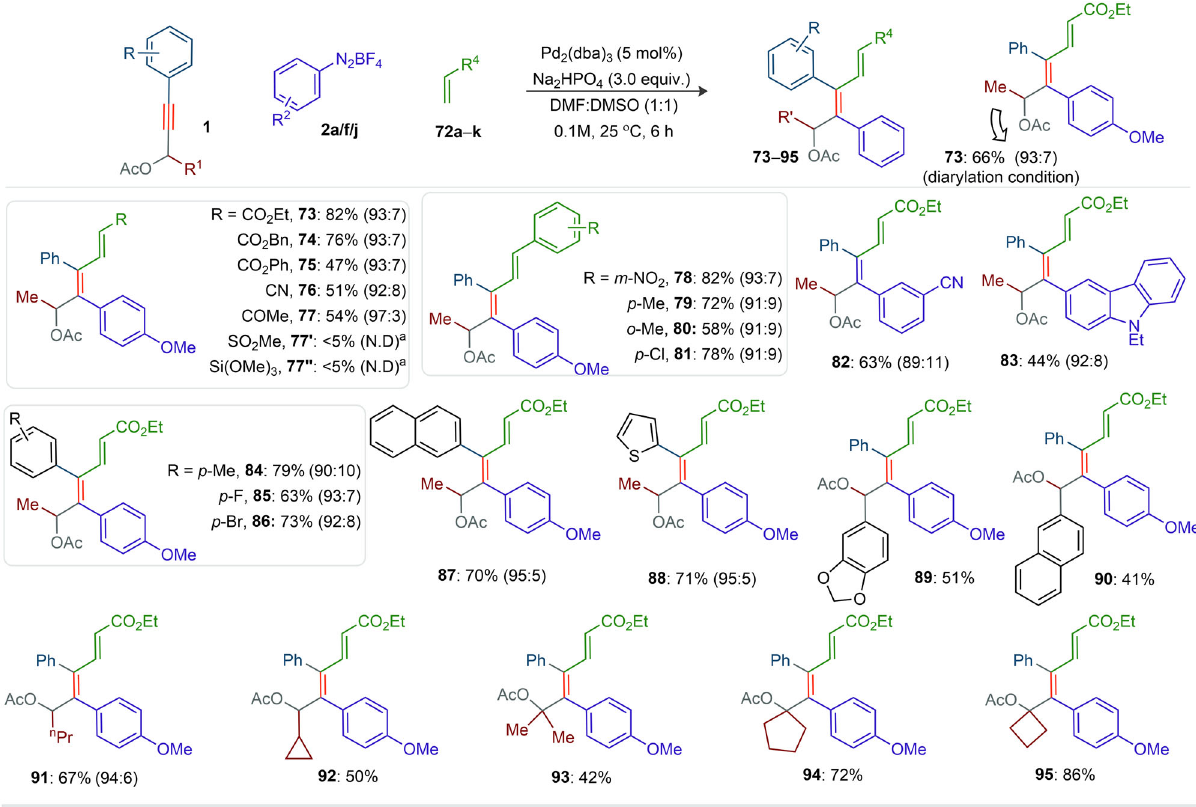
Fig. 4 Scope of aryl-ole fi nation of alkynes a . All yields correspond to products isolated as a single stereo- and regioisomer, unless otherwise stated. a 1 (0.3 mmol), 2 (0.9 mmol), 72 (0.45 mmol). a Hydroarylation product was observed (see 117 , Fig. 6d). ND not